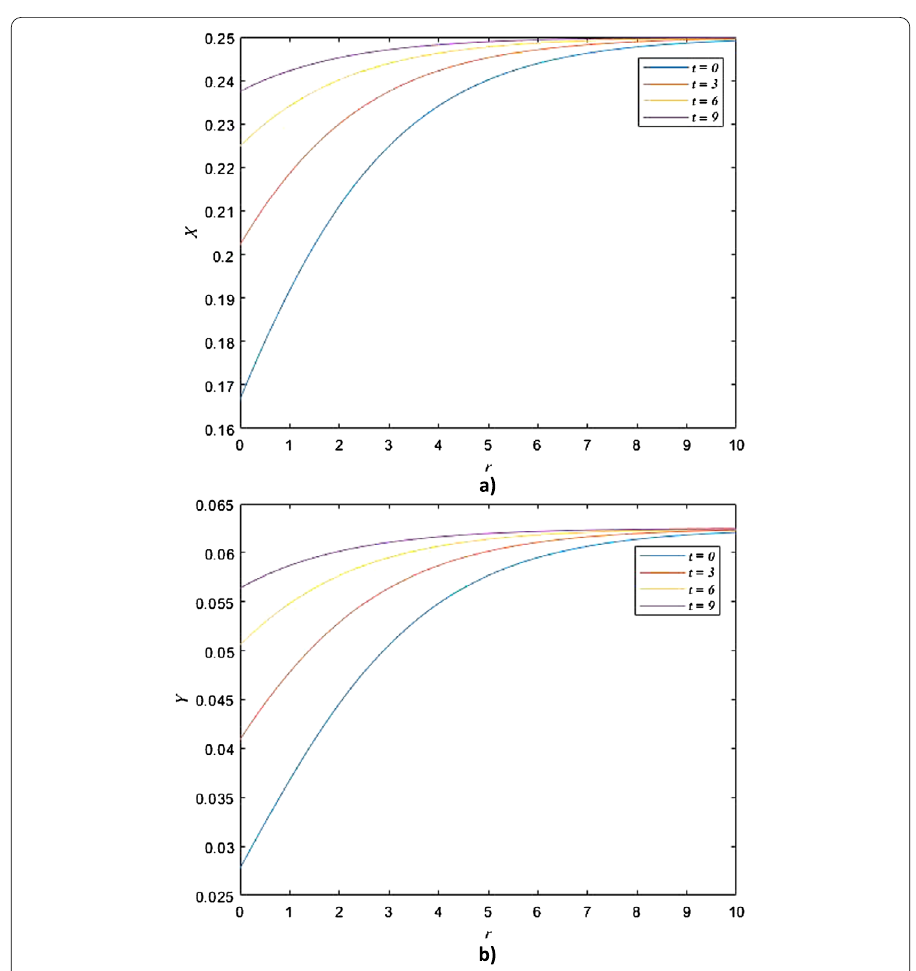
Figure 3 Traveling wave solution. Traveling waves of ( a ) fish density x , and ( b ) recruitment intensity y , as functions of spatial position r for t from 0 (furthest left) to 9 (furthest right), given by (39)–(40). The waves are seen moving from right to left. Here, a = 1